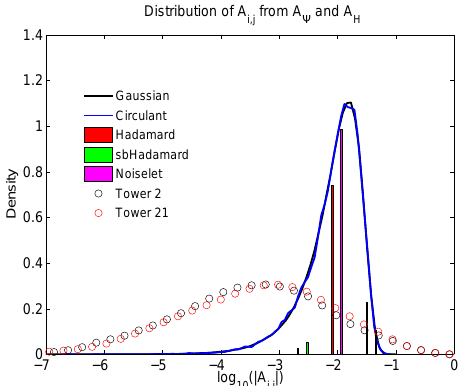
Figure 5. Comparison of the distribution of the elements of A (cid:57) and A (cid:56) . We see that Gaussian and circulant random matrices lead to continuous distributions, whereas Hadamard, scrambled-block Hadamard (sbHadamard) and noiselets serving as sampling matrices lead to A (cid:57) where the elements assume discrete values. In contrast, the elements of A H (cid:48) assume values which are spread over a far larger range, some of which are quite close to 1 while others are very close to 0.